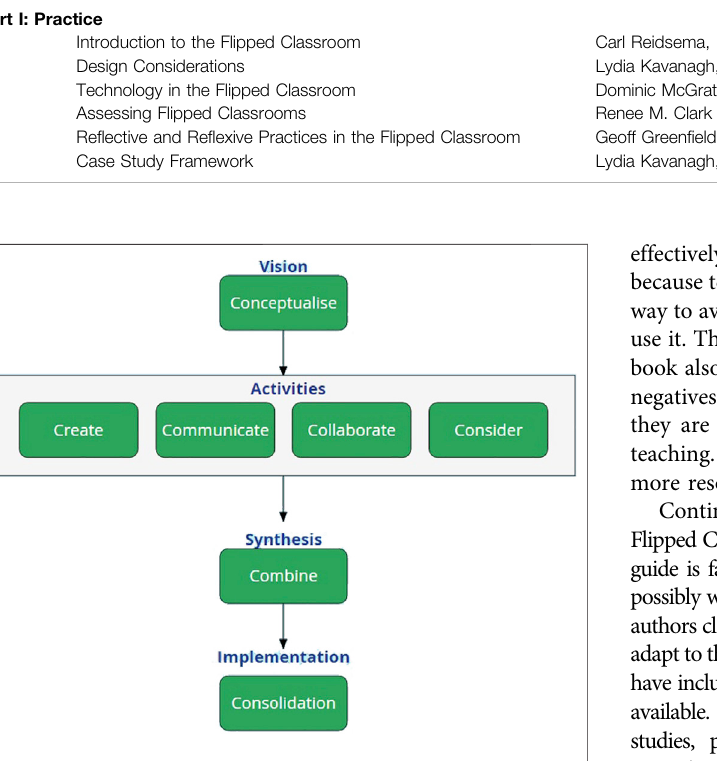
FIGURE 1 | The 7Cs of Learning Design adopted from Reidsema et al.